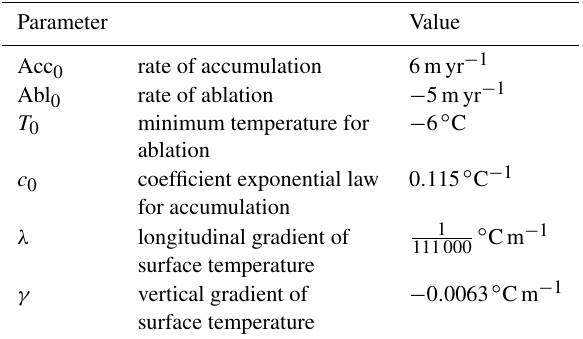
Table A1. List of parameter values used for the parameterised sur- face mass